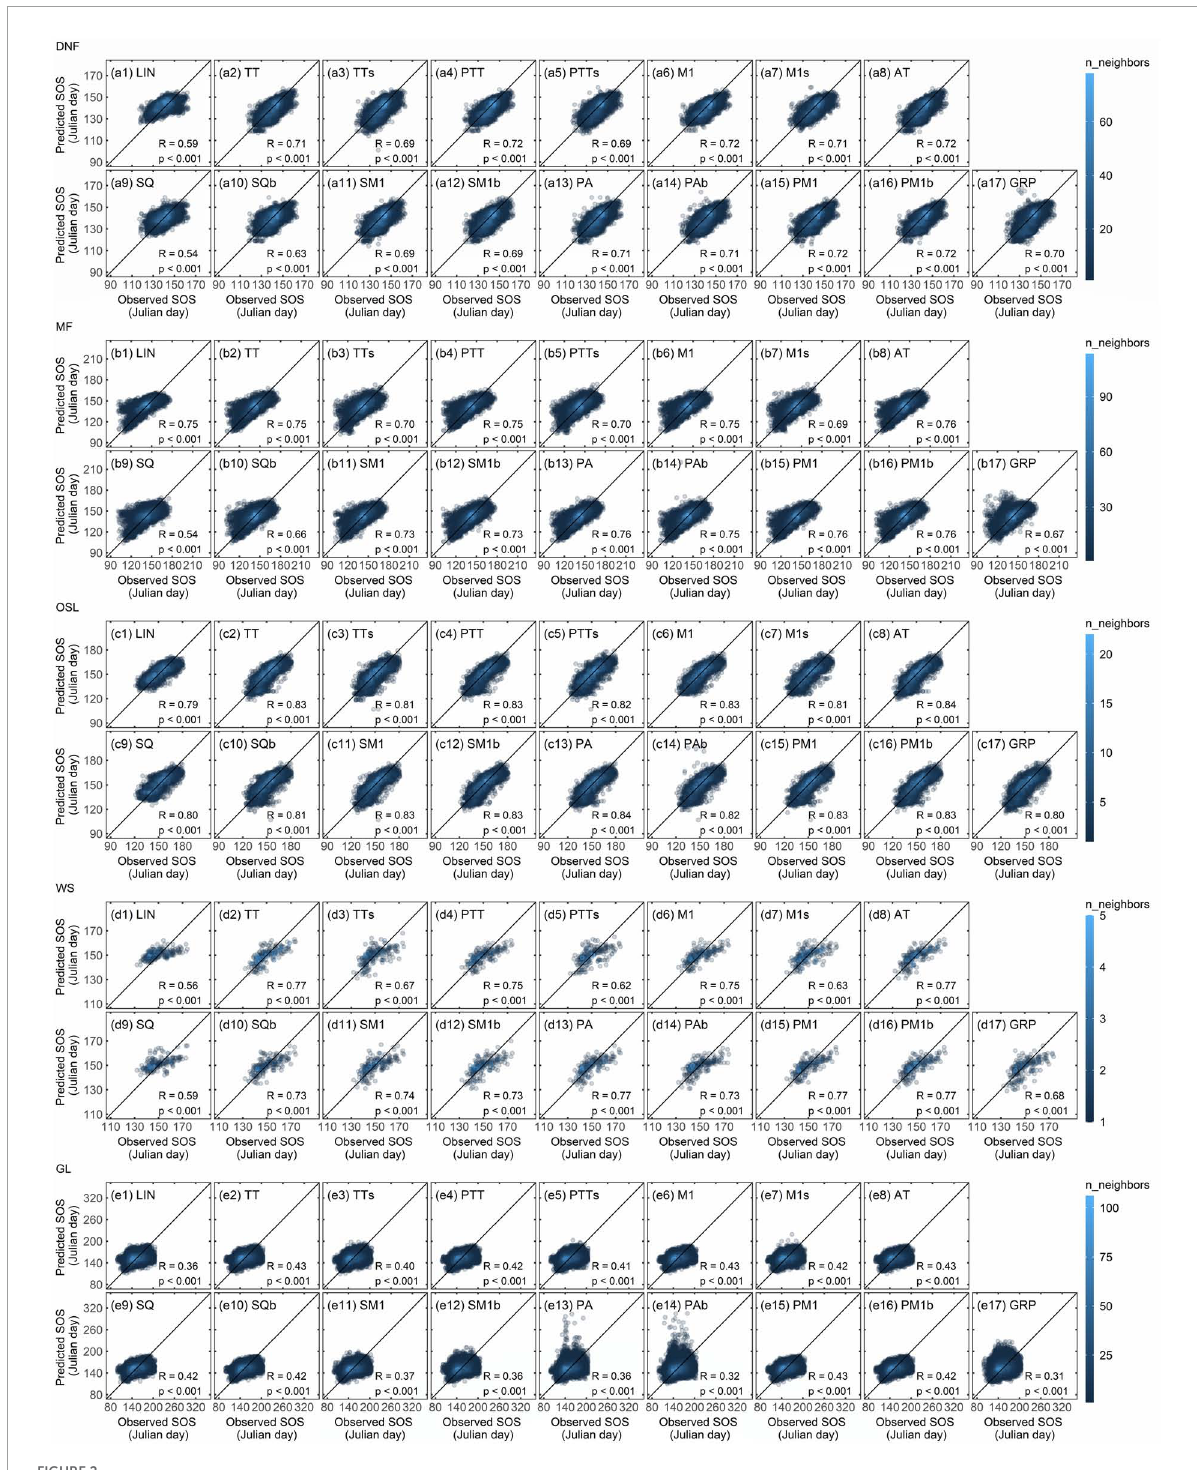
FIGURE2 Scatter plot of the model-predicted start of the growing season (SOS) and satellite-derived SOS. The dots in each graph indicate all pixels for each vegetation type across the model training period. Figures a1–a17, b1–b17, c1–c17, d1–d17 and e1–e17 show the prediction results of the 17 models of deciduous needleleaf forest (DNF), mixed forest (MF), open shrublands (OSL), woody savannas (WS), and grasslands (GL), respectively. The solid lines in the figures are 1:1 lines. A point on the line indicates that the satellite-derived SOS is equal to the model-predicted SOS. n_neighbors indicates the number of points within the radius of each data point, which reflected the degree of aggregation of data points. It was drawn by geom_pointdensity in the ggpointdensity package (version 0.1.0) in R, with the radius adjustment parameter set to